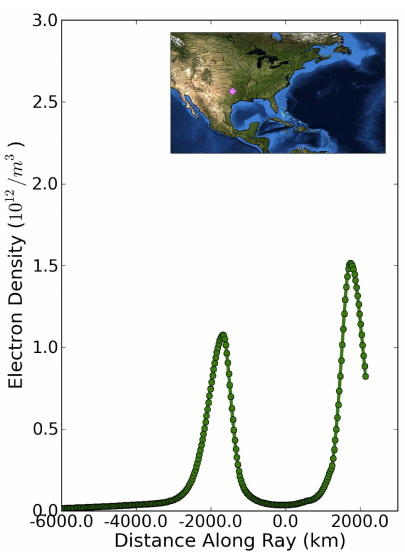
Fig. 2. Electron density versus distance along the simulated raypath. The curves for L1 and L2 frequencies overlay nearly exactly on this scale. The location of the occultation tangent point is shown in the